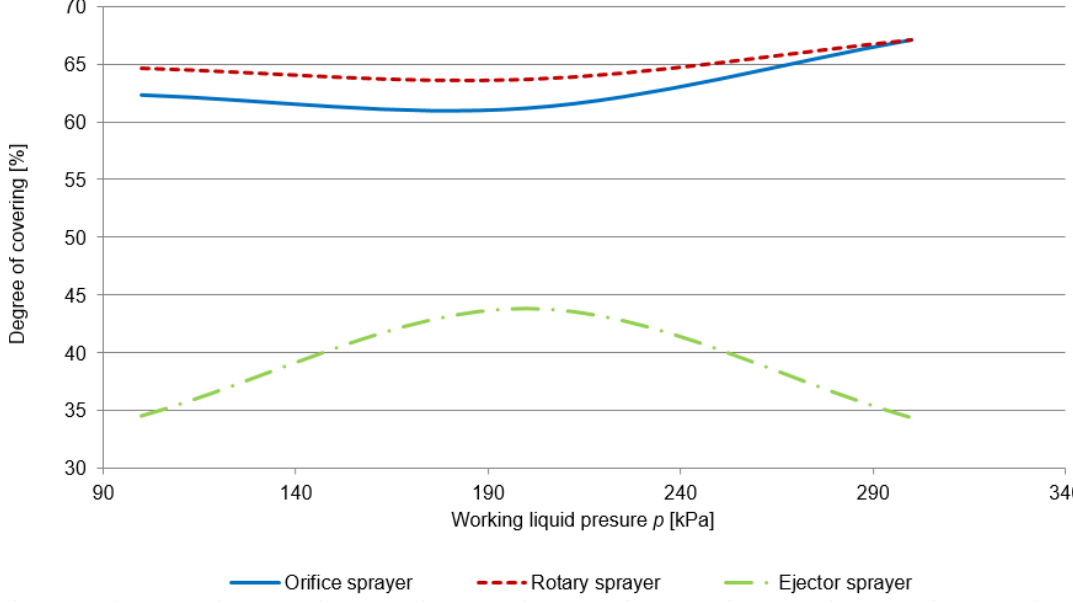
Figure 8. The degree of seed potato covering with the dressing substance for the electronically controlled sprayer valve with an additional supply of compressed air the seed potato fall positioned at a distance S of 100 mm from the seed potato fall axis.